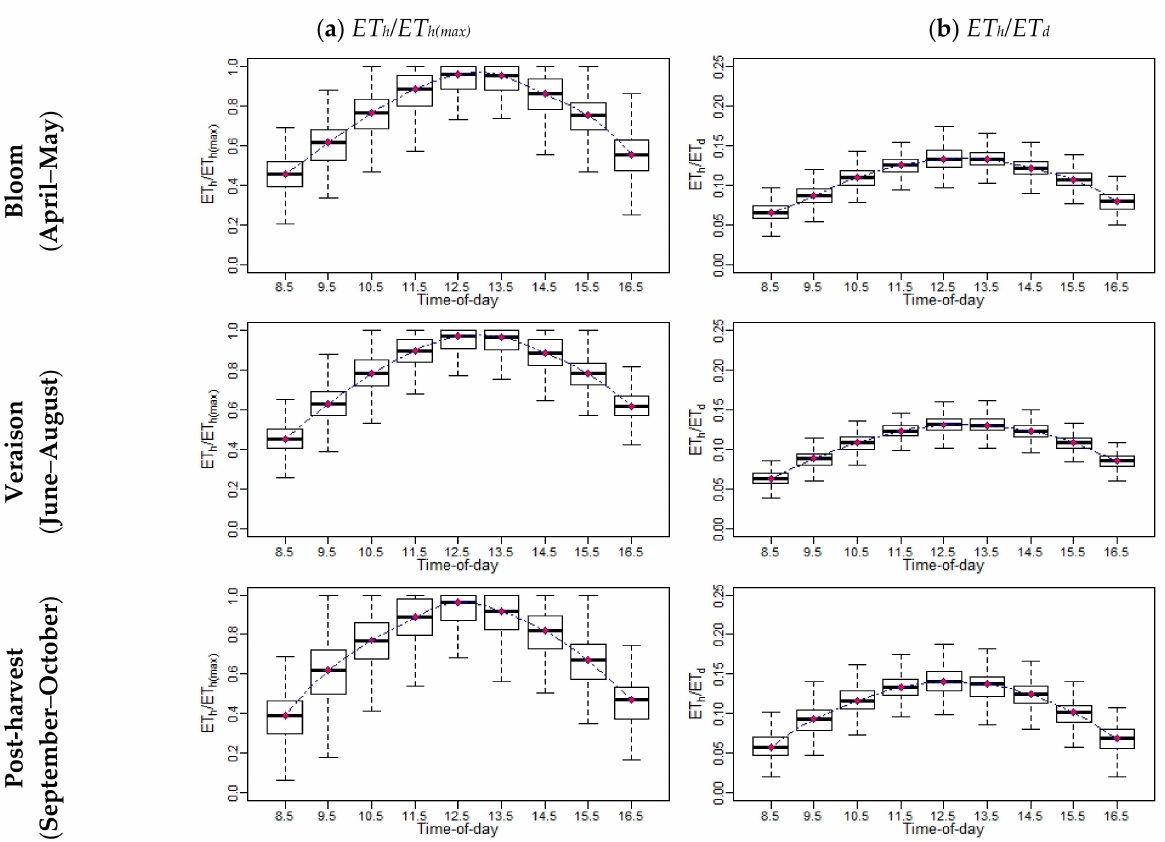
Figure 6. An example of the diurnal variations of ( a ) and ET h /ET h(max ) and ( b ) ET h /ET d at different phenological vine stages for Sierra Loma Sites 1 and 2 between 2014 and